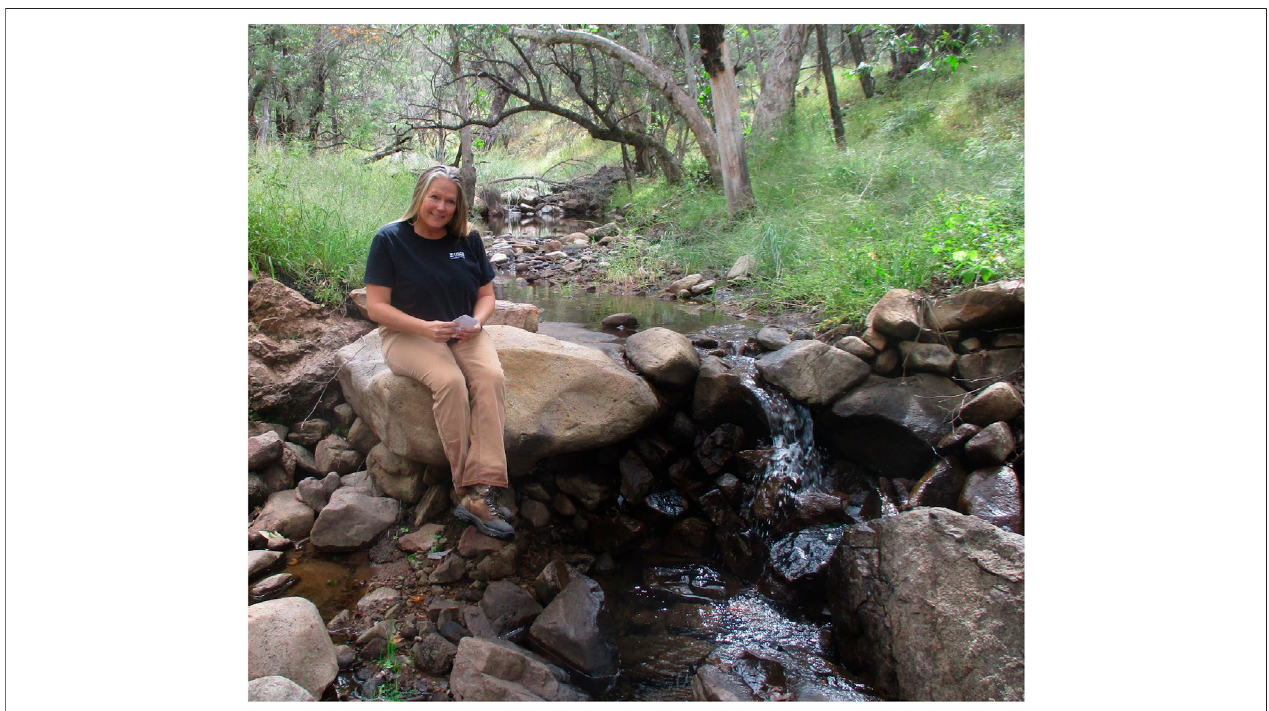
Frontiers in Environmental Science |